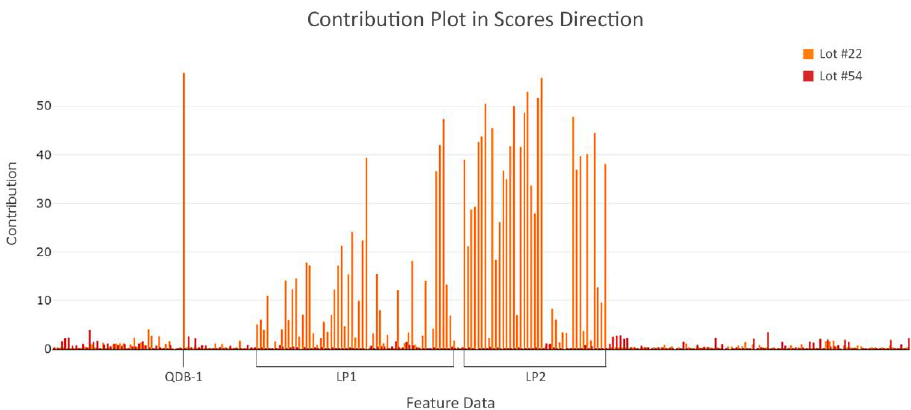
Figure 9. Contribution plot in the scores direction, showing which feature data (x-axis) has most impact to the contribution (y-axis) for the outlier lot and the lot closest to the center of the model. All 252 variables of lot #22 (orange bars) and lot #54 (red bars) are depicted. A strong pattern for lot #22 is identified, which is nonexistent in lot #54. Of particular note is ‘QDB-1’ and the extracted plateau features from variable LP1 and LP2, which exhibit a high contribution (≤52) and lead to the outlying score of lot #22.